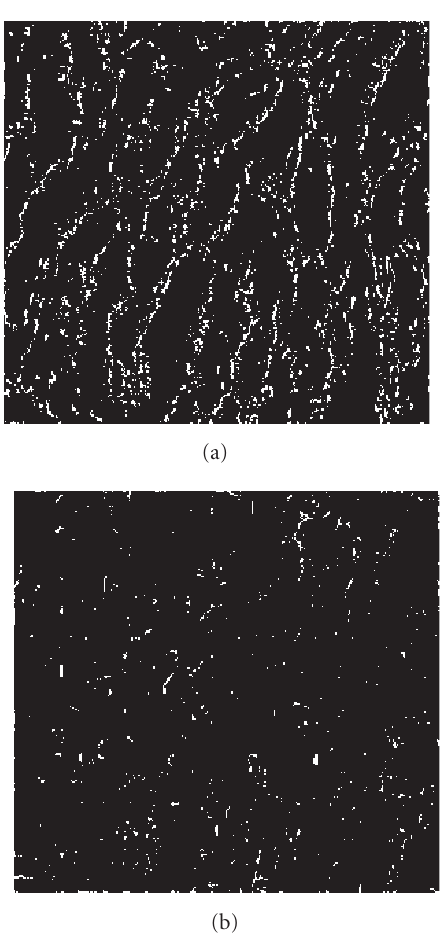
Figure 3.2. Extraction of peaks and pits from the DEM of Great Basin. (a) The extracted peaks. (b) The extracted